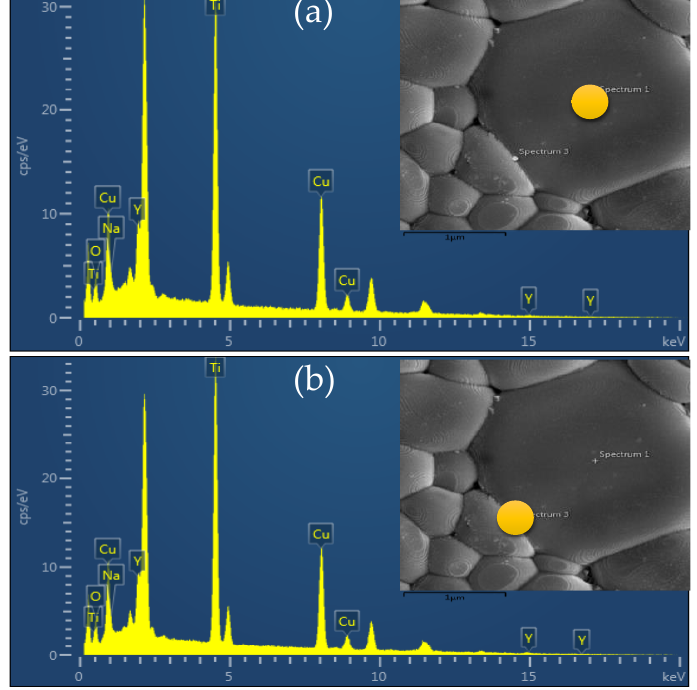
Figure 7. EDX spectra of NYCTO + xTiO 2 ceramic with x = 0.2 detected at ( a ) grain and ( b ) GB; insets show the detected points in the microstructure.